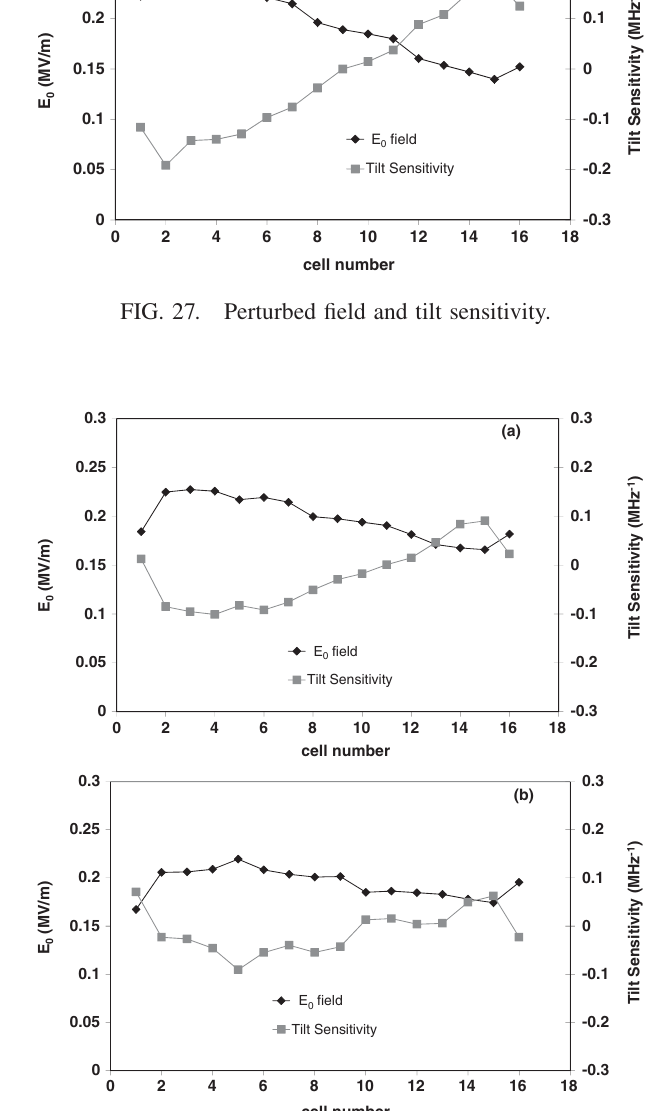
FIG. 28. Gap PC - DT ¼ 15 mm is too small for both 5 PCs (a) and 7 PCs (b)